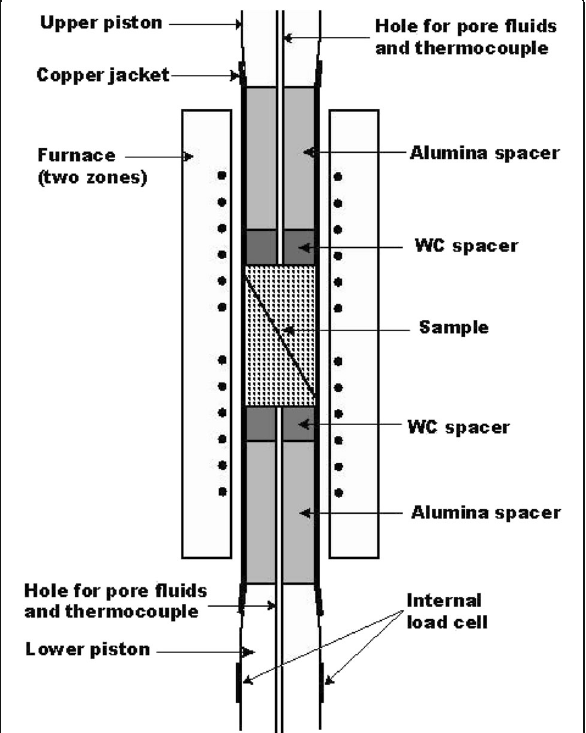
Fig. 1 Cross section of the sample assembly of the triaxial deformation apparatus used in this study. A layer of ground quartz or feldspar “ gouge ” (~1mm thick) was placed between alumina driving blocks pre-cut from an alumina cylinder (20mm diameter, 40mm length) at 30° to its long axis and deformed under dry or wet conditions at temperatures from room temperature (20°C) to 600°C. In the wet experiments, pore pressure was provided by distilled water introduced from outside the pressure vessel through holes drilled through the alumina spacers. The whole sample assembly was sealed by annealed copper tube with 0.2mm in thickness. The sample assembly and furnace were placed inside the pressure vessel. A detailed description of the apparatus is provided by Masuda et al.